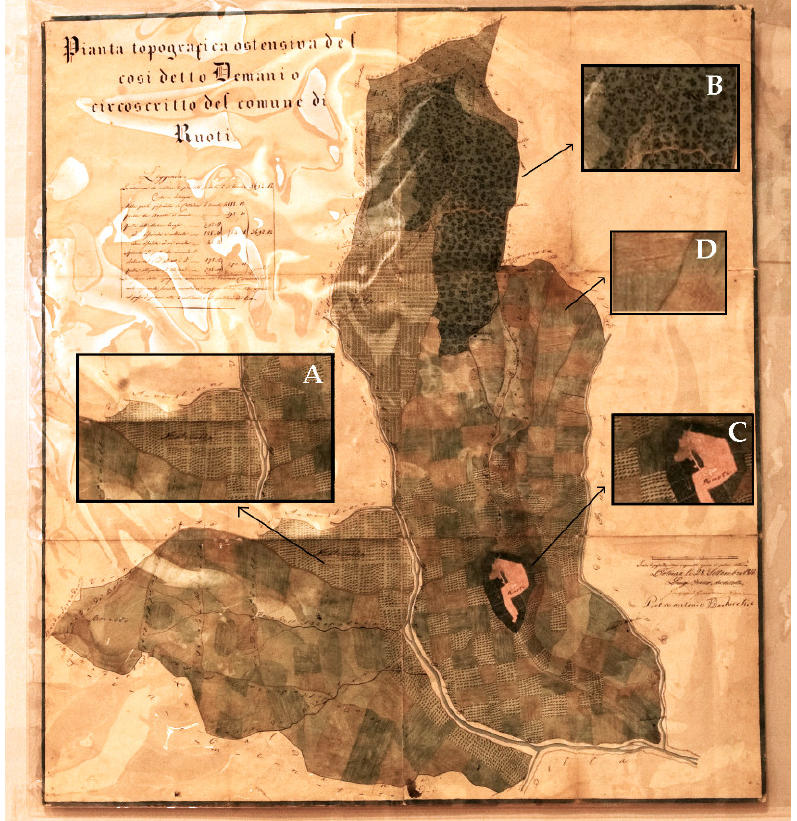
Figure 2. Historical map of 1848 preserved by a protective film with some zoom on details. In the first detail ( A ), it is possible to observe the representation of olive groves and vineyards and part of the river zone; in the second detail ( B ), the representation of woodlands; in the third detail ( C ), instead the urban area of Ruoti and, in the fourth detail ( D ), the arable land and pastures.